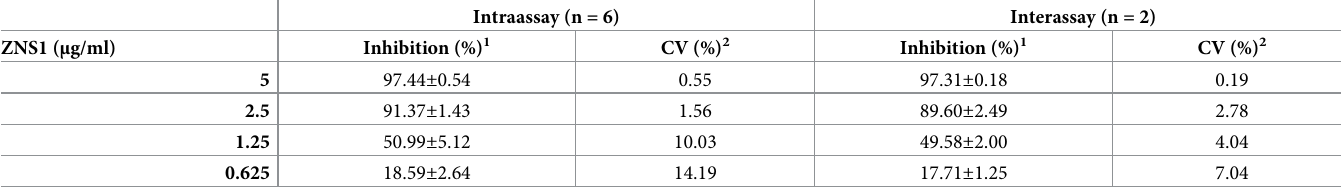
Table 2. Intraassay and interassay variation of denatured ZNS1 standards analyzed by indirect competitive ELISA with 1F5